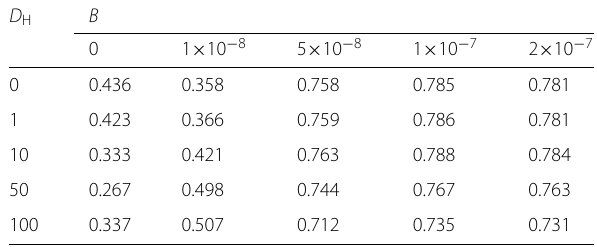
Table 3 Damping rates of the SSH disturbances per year, i.e., exp ( − r mn × 1 year ) , with respect to the vertical and